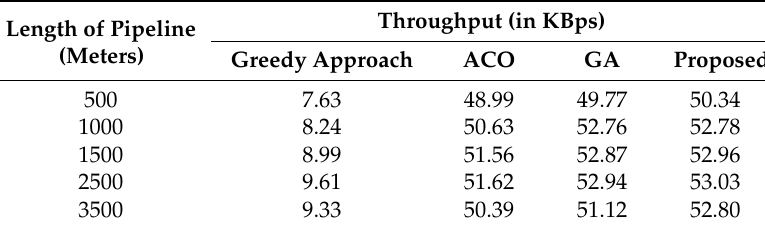
Table 6. Comparison of Throughput (Range 50 m).